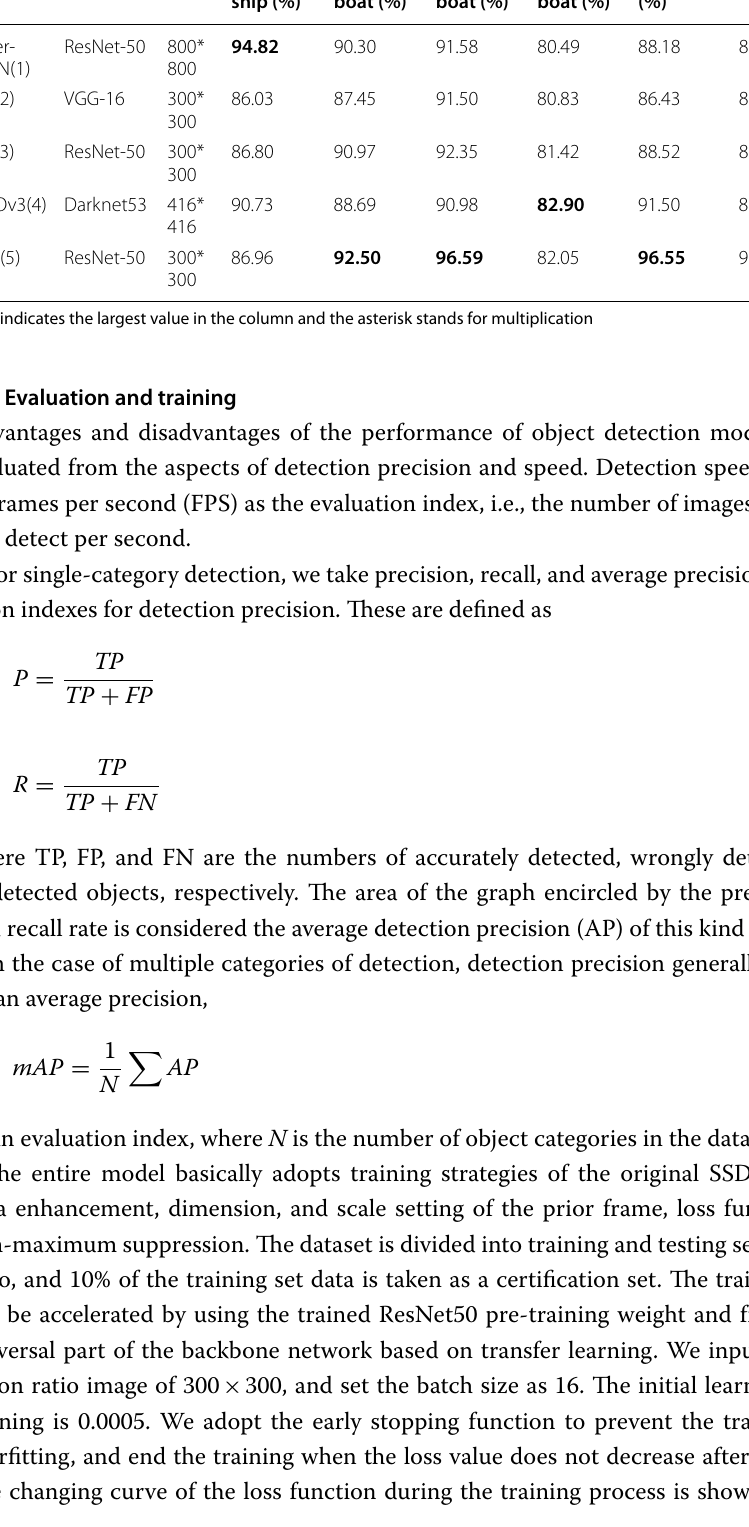
Table 5 Results of different detection algorithms